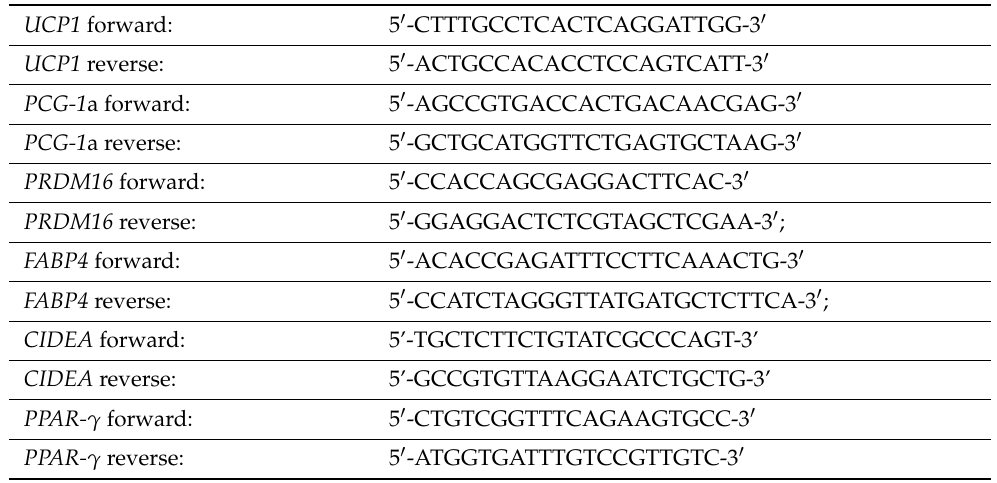
Table 1. Primer sequences used for RT-PCR